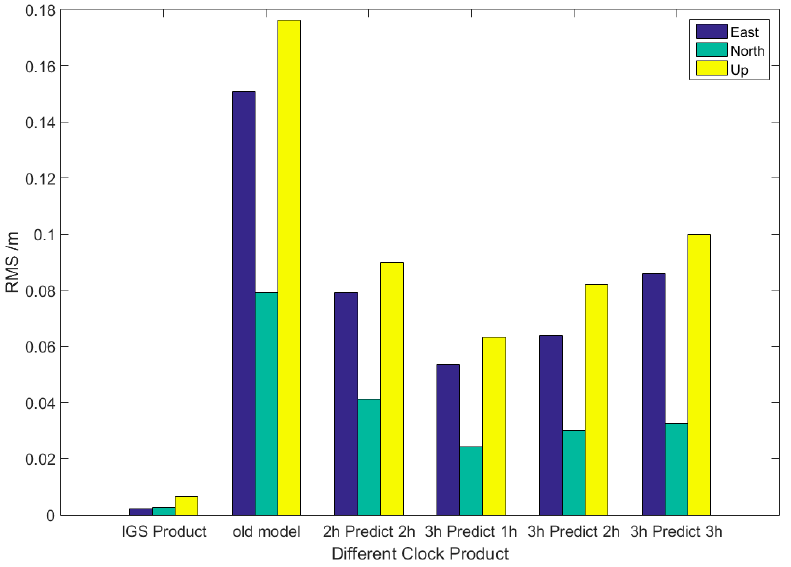
Figure 8. Precise point positioning (PPP) precision of different clock prediction products.